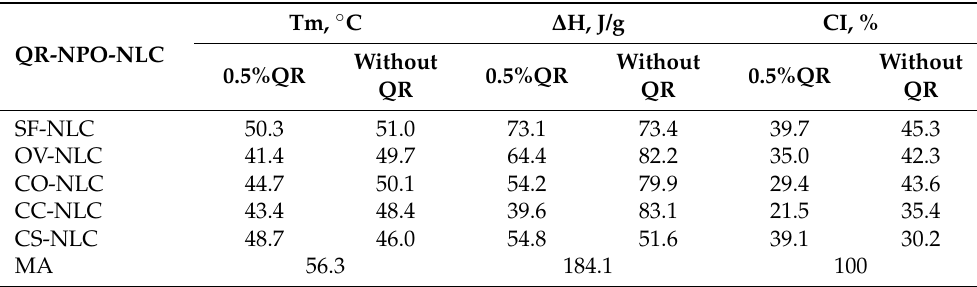
Table 2. Melting temperature (Tm, ◦ C), enthalpy ( ∆ H, J/g), and crystallinity index (CI, %) of NLC- NPOs with (0.5%, w / v ) and without